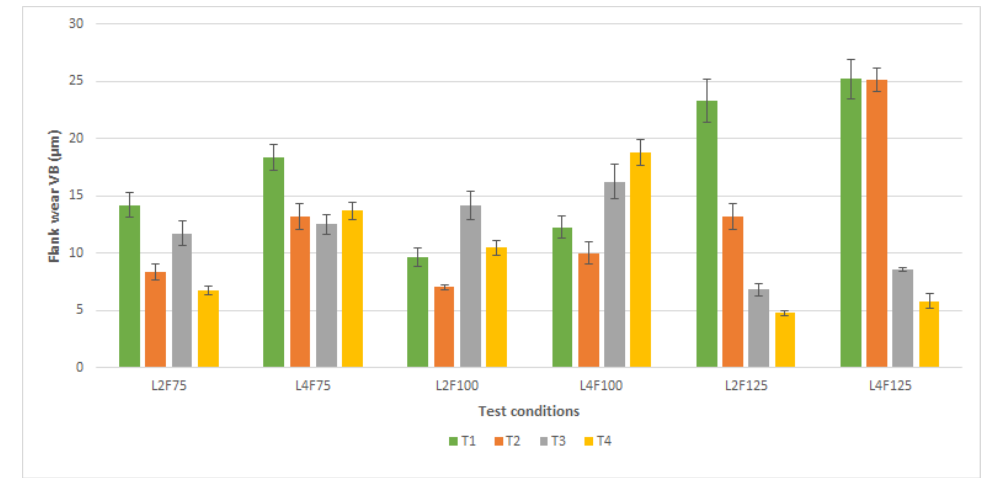
Figure 21. Average values of Ra, measured in the radial direction for T1, T2, T3 and T4 tools, for the test conditions conducted at 2-m cutting length ( a ); and 4-m cutting length ( b ).